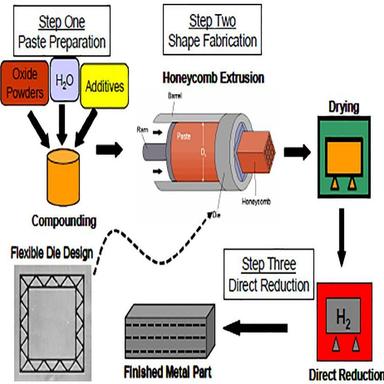
Schematic diagram of linear cellular alloy manufacturing technique .